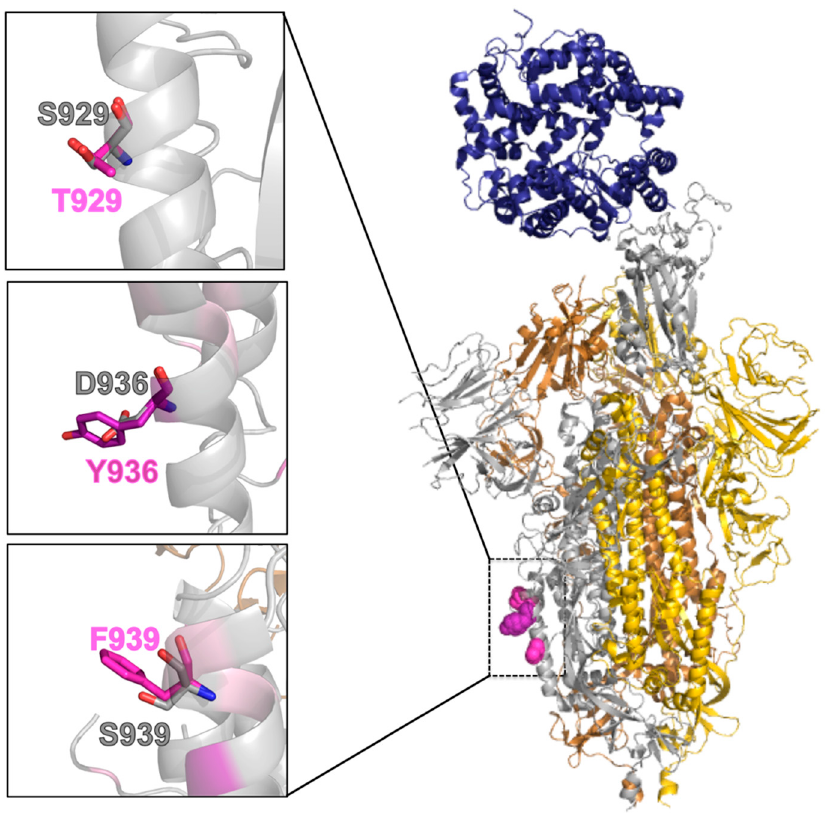
Figure 3. Mutants in the pre-fusion conformation. Right: Cartoon representation of the SARS-CoV-2 S protein in its pre-fusion trimeric conformation (the three monomers are colored in silver, gold, and copper, PDB ID: 6VSB), with the structure of the RBD bound to the ACE2 receptor (in blue, PDB ID: 6M0J) superimposed on its chain A. The most frequent mutations in the HR1 fusion core in GISAID on 15 February are colored purple and shown as a “dots” representation for chain A. Left: Focus on the structural context of each wild-type residue (silver sticks) and corresponding mutant (purple sticks).